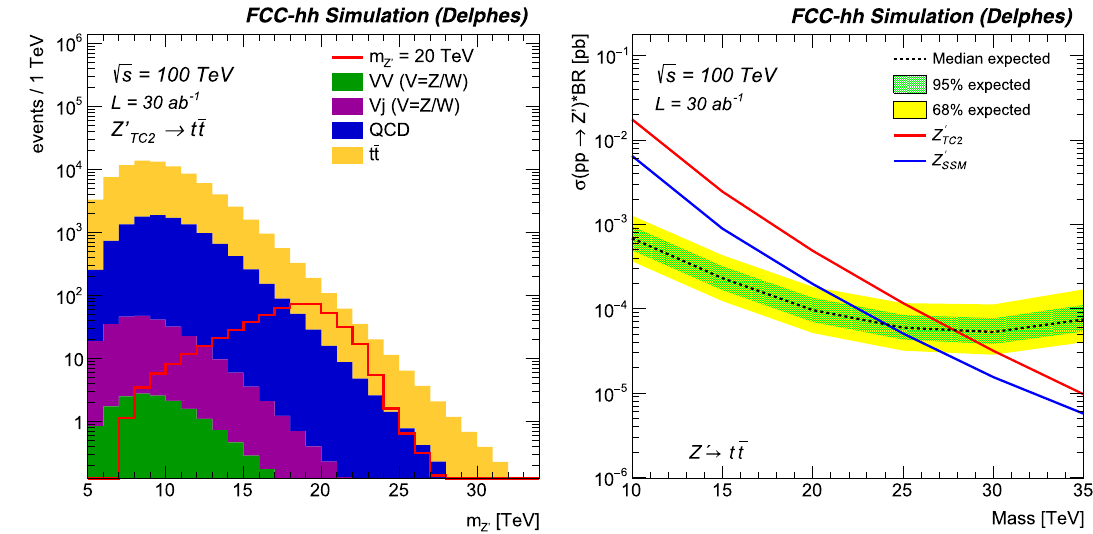
Fig. 7 Invariant mass distribution of the two selected top-jets (left) for a 20TeV signal (left), 95% CL limit versus mass (right)